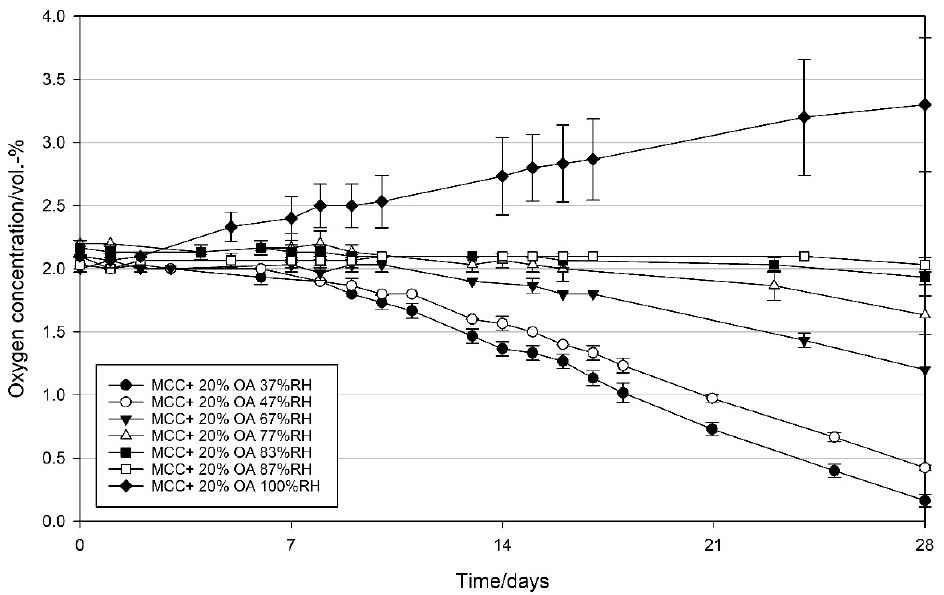
Figure 7. Oxygen concentration in packages containing 1 g modified calcium carbonate (MCC) loaded with 20 wt% oleic acid stored at 21 °C, and 37–100% RH in the package. Packed under modified atmosphere (MAP, 2 vol.-% O 2 , rest N 2 ; headspace 250 mL). Mean values and standard deviation (n = 3).